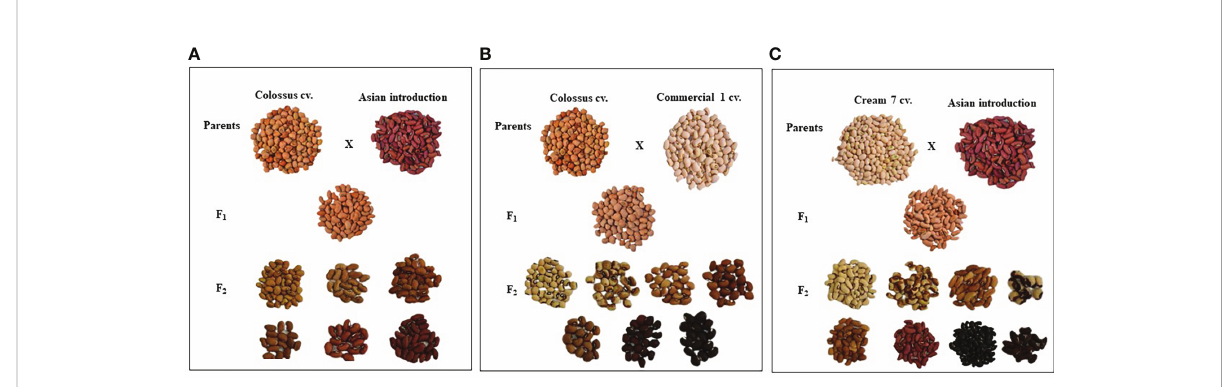
FIGURE 2 The diversi fi cation of seed characteristics of the parental genotypes, F 1 and F 2 of the crosses, (A) Colossus cv. x Asian Introduction, (B) Colossus cv. x Commercial 1and (C) Cream 7 cv. x Asian